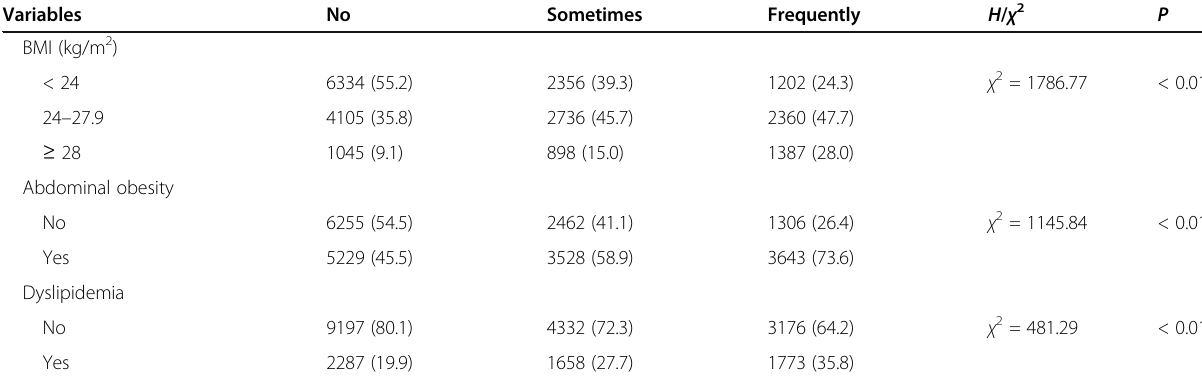
Table 1 Characteristics of participants by groups of self-reported snoring (Continued) Variables